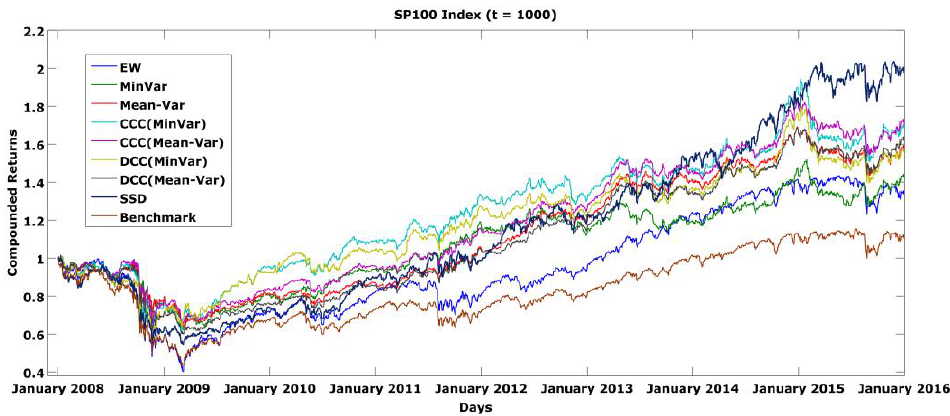
Figure 4. Compounded (on daily basis) returns of portfolios consisting of SP100 stocks, t = 1000.